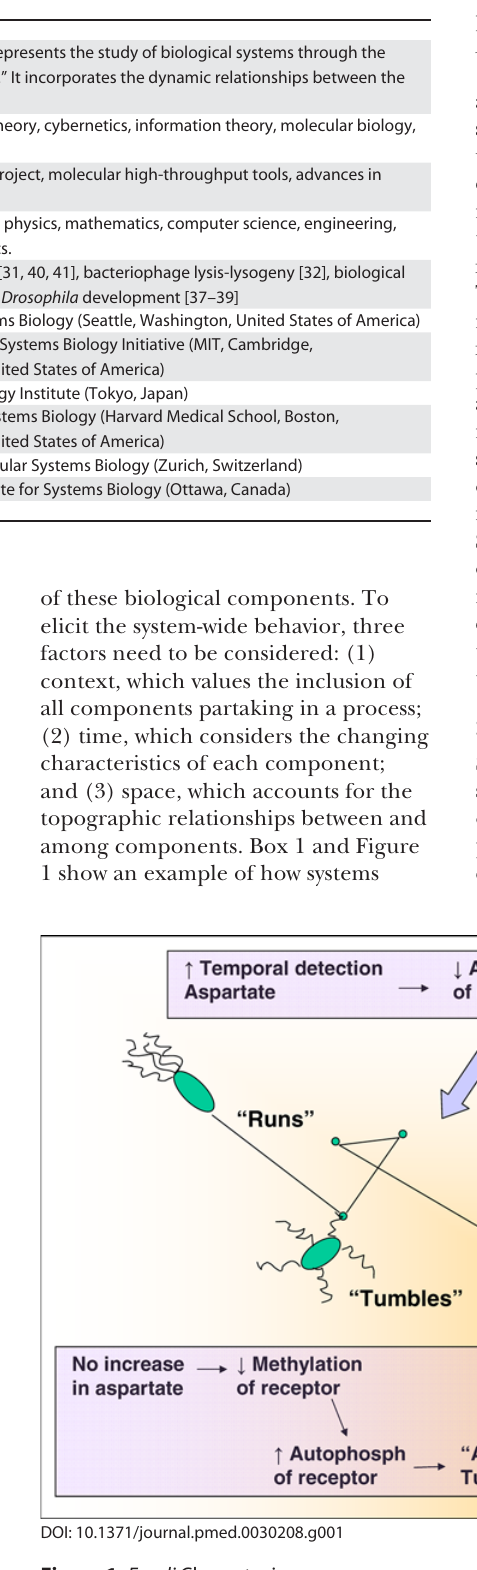
Figure 1. E. coli Chemotaxis E. coli has been observed to migrate toward areas of higher aspartate concentrations through a series of “runs” and “tumbles” (see Box 1). Autophosph,